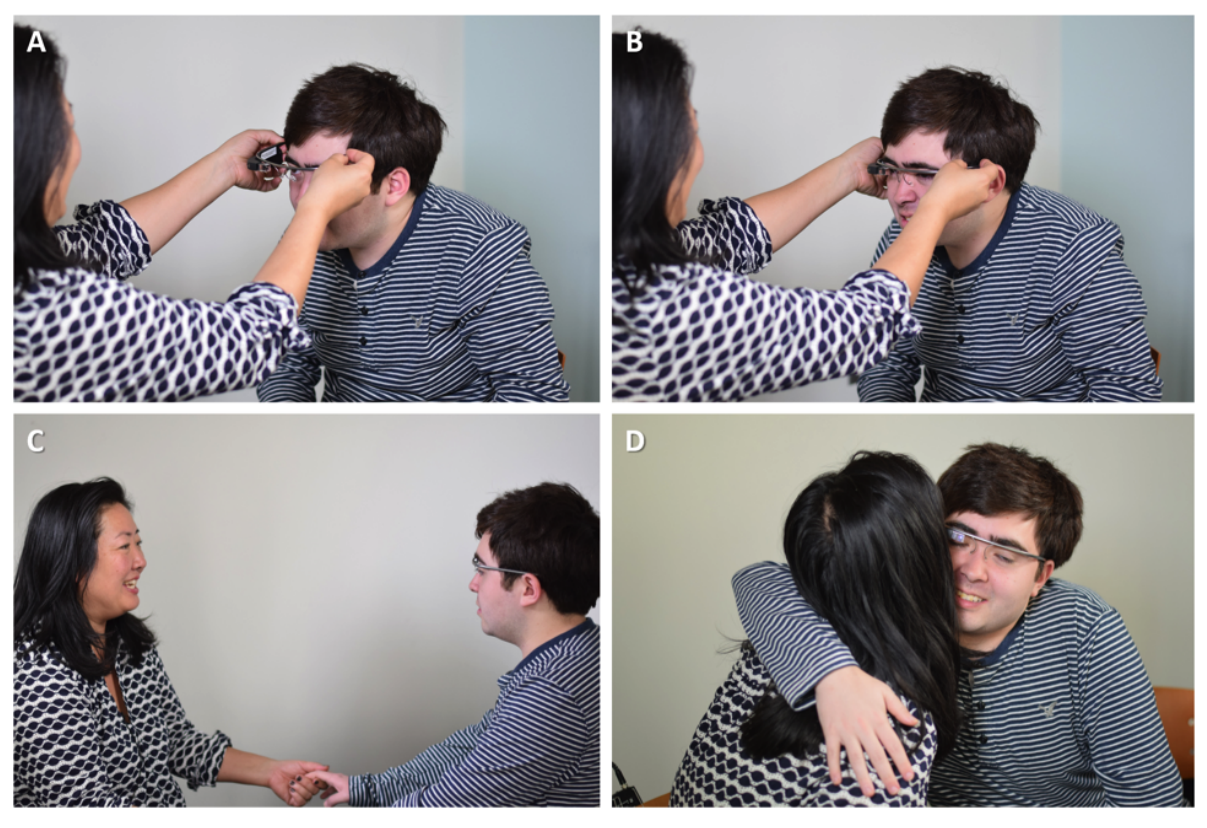
Figure 2. Caregiver assisting user in wearing Brain Power Autism System smartglasses during testing (A, B). User demonstrated tolerability on all 3 measures and was witnessed to spontaneously hug his caregiver during use of social communication app use (C, D). Pictures used with user/caregiver